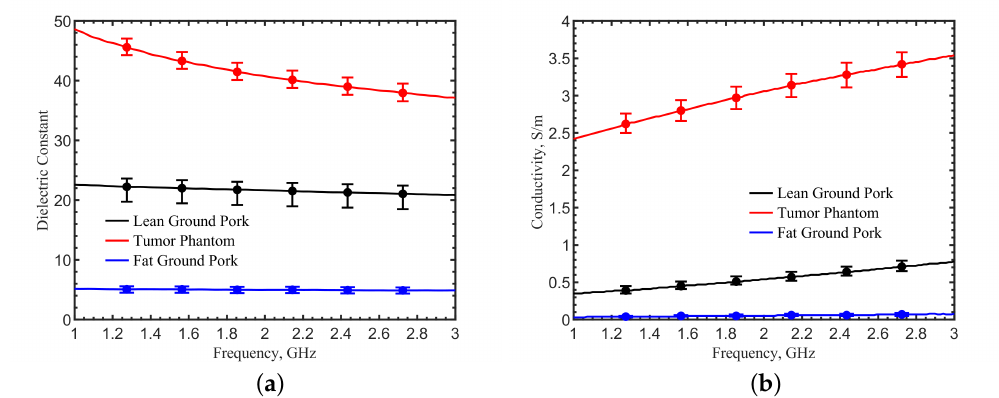
Figure 12. Measurements of dielectric properties: ( a ) dielectric constant and ( b ) conductivity for lean ground pork, tumor phantom, and fat ground pork, which mimic the breast skin, normal breast tissue, and breast tumor in experiments. The error bars were obtained from 5 measurements with respect to averaged values.